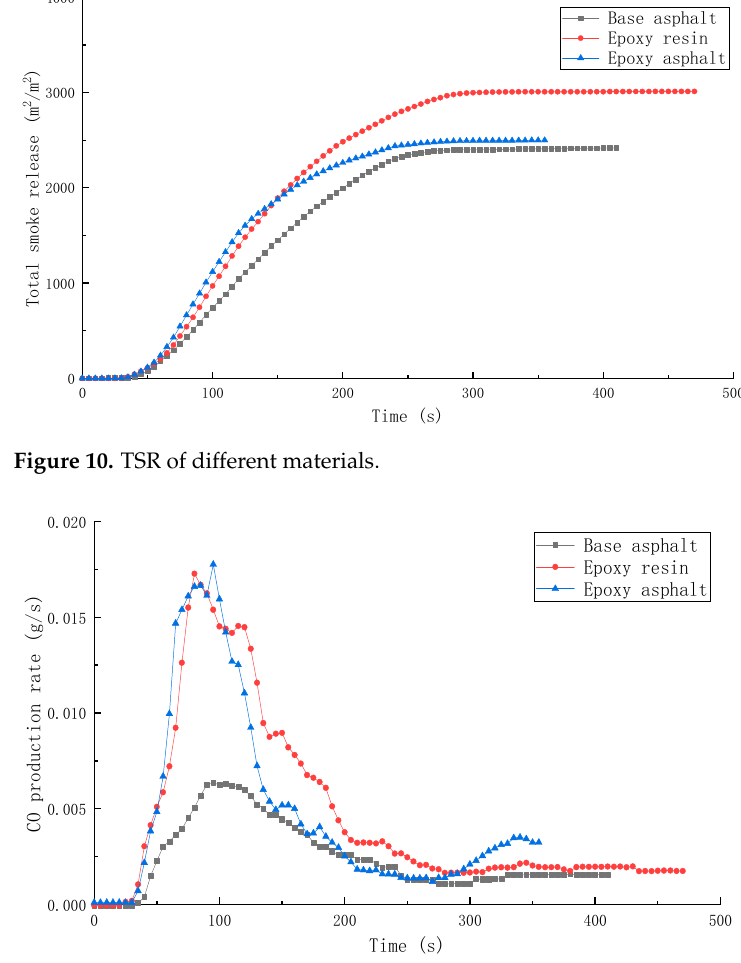
Figure 11. CO production rate (COP) of different materials.